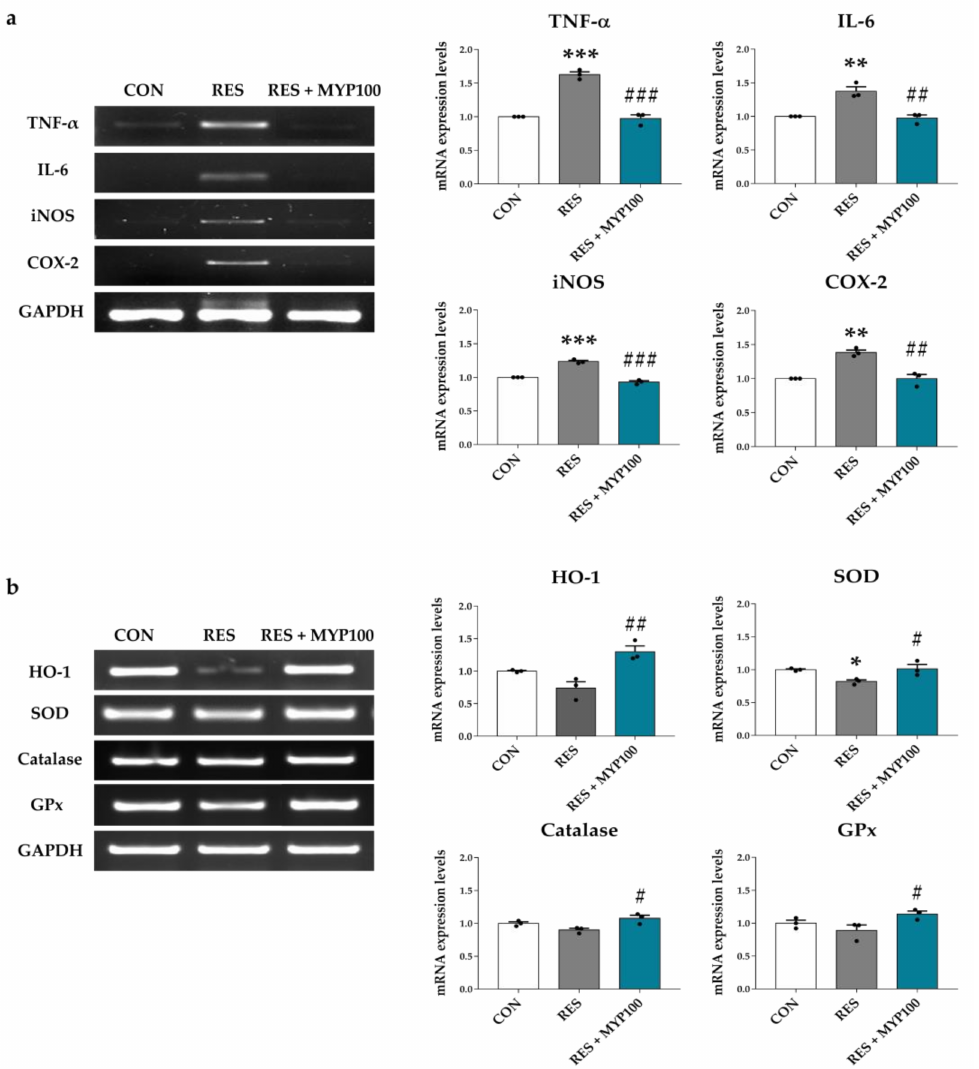
Figure 12. Modulation of anti-inflammation- and anti-oxidation-related genes by myelophil (MYP) treatment in the spleen and liver. ( a ) Expression of anti-inflammation-related mRNAs such as TNF- α , IL-6, iNOS, and COX-2 in spleen was significantly reduced after MYP treatment. ( b ) Anti-oxidation-related mRNAs such as HO-1, SOD, catalase, and GPx in the liver were upregulated after MYP treatment. Gene expression was quantitatively analyzed using Image Lab software. CON: control ( n = 3), RES: 2 mg/kg of reserpine treatment ( n = 3), RES + MYP100: 2 mg/kg of reserpine followed by 100 mg/kg of MYP treatment ( n = 3). Data are expressed as means ± SEM. One-way ANOVA test with Tukey post hoc tests was executed. * p < 0.05, ** p < 0.01, *** p < 0.001 vs. CON; # p < 0.05, ## p < 0.01, ### p < 0.001 vs.